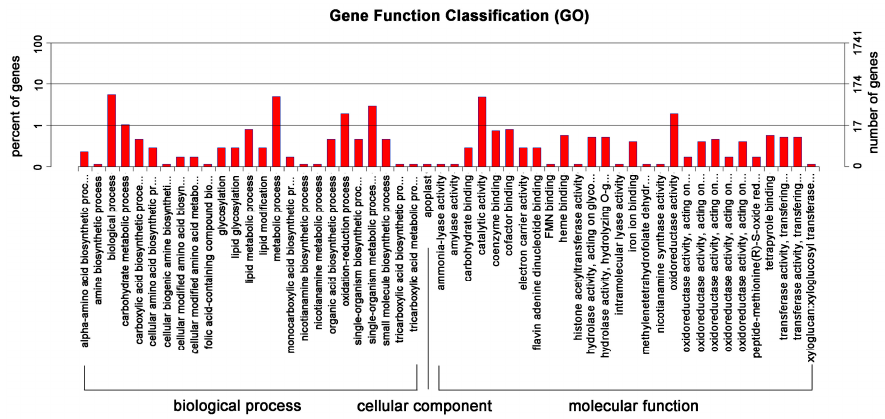
Figure 3. Classification of the DEGs from the IPG/TPG comparison group into GO terms. Forty-one annotated DEGs from the IPG/TPG groups were classified into the GO categories to show the most affected gene functions in these two growth conditions. Table 1. List of the five most effected GO accessions in each GO categories.